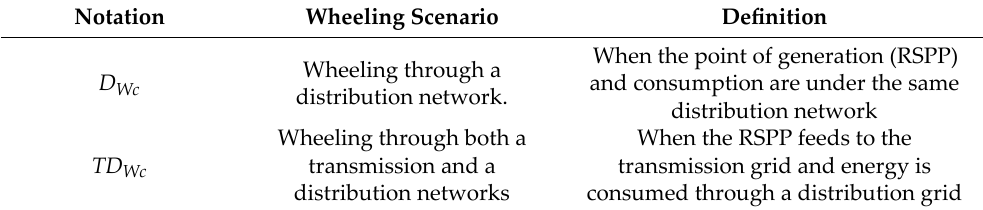
Table 4. Wheeling scenarios based on consumption and RSPP feed‑in